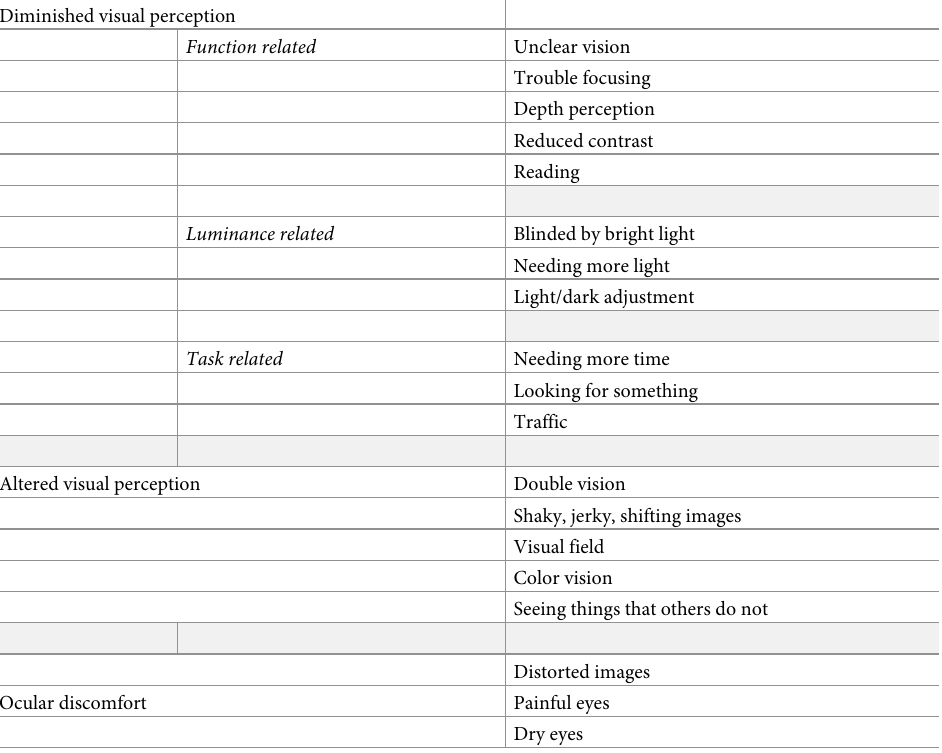
Table 2. One-factor model, three-factor model and five-factor model with belonging items as found by Huizinga et al. (2020)